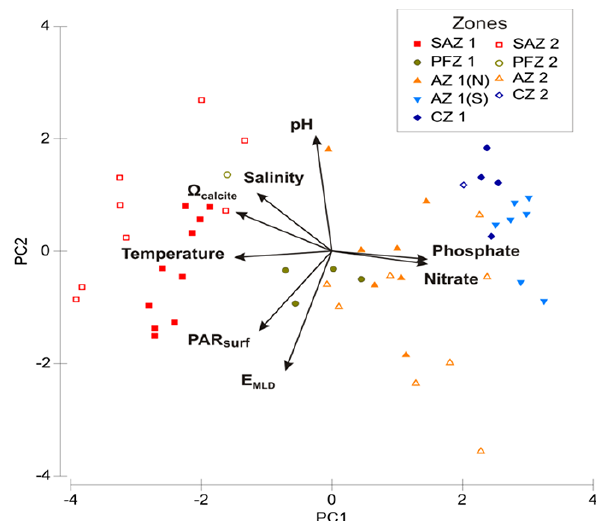
Figure 3. Ordination from principal component analysis of environ- mental variables. Environmental gradients are displayed as arrows indicating the direction of greatest change. Filled symbols represent samples from the different zones of Transect 1, and empty symbols samples are from Transect 2. SAZ is the Subantarctic zone, PFZ is the Polar Frontal Zone, AZ is the Antarctic Zone and CZ is the Con- tinental Zone. (N) and (S) denote the northern and southern part of the AZ on Transect 1, as a result of the two branches of the Polar Front. Arrows and length of the arrows indicate the relative influ- ence of each environmental variable on the PC axis; e.g. variables which align with PC-1 (temperature, phosphate, nitrate) strongly in- fluence PC-1. Arrows which go in opposite directions indicate op- posing relationships; e.g. temperature and nutrient concentrations are negatively